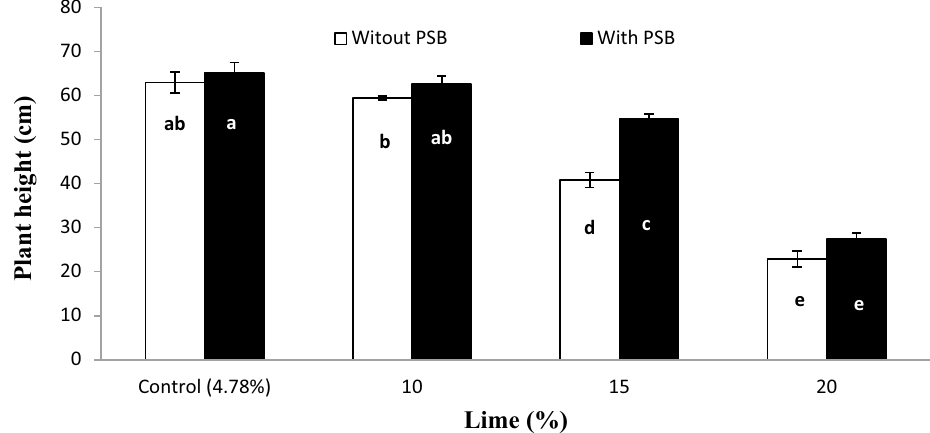
Figure 1. Interactive effect of lime and P sources on plant height per pot. Graph bars having different letters are significantly different at α = 0.05. Errors bar represent standard error for the mean of three values.